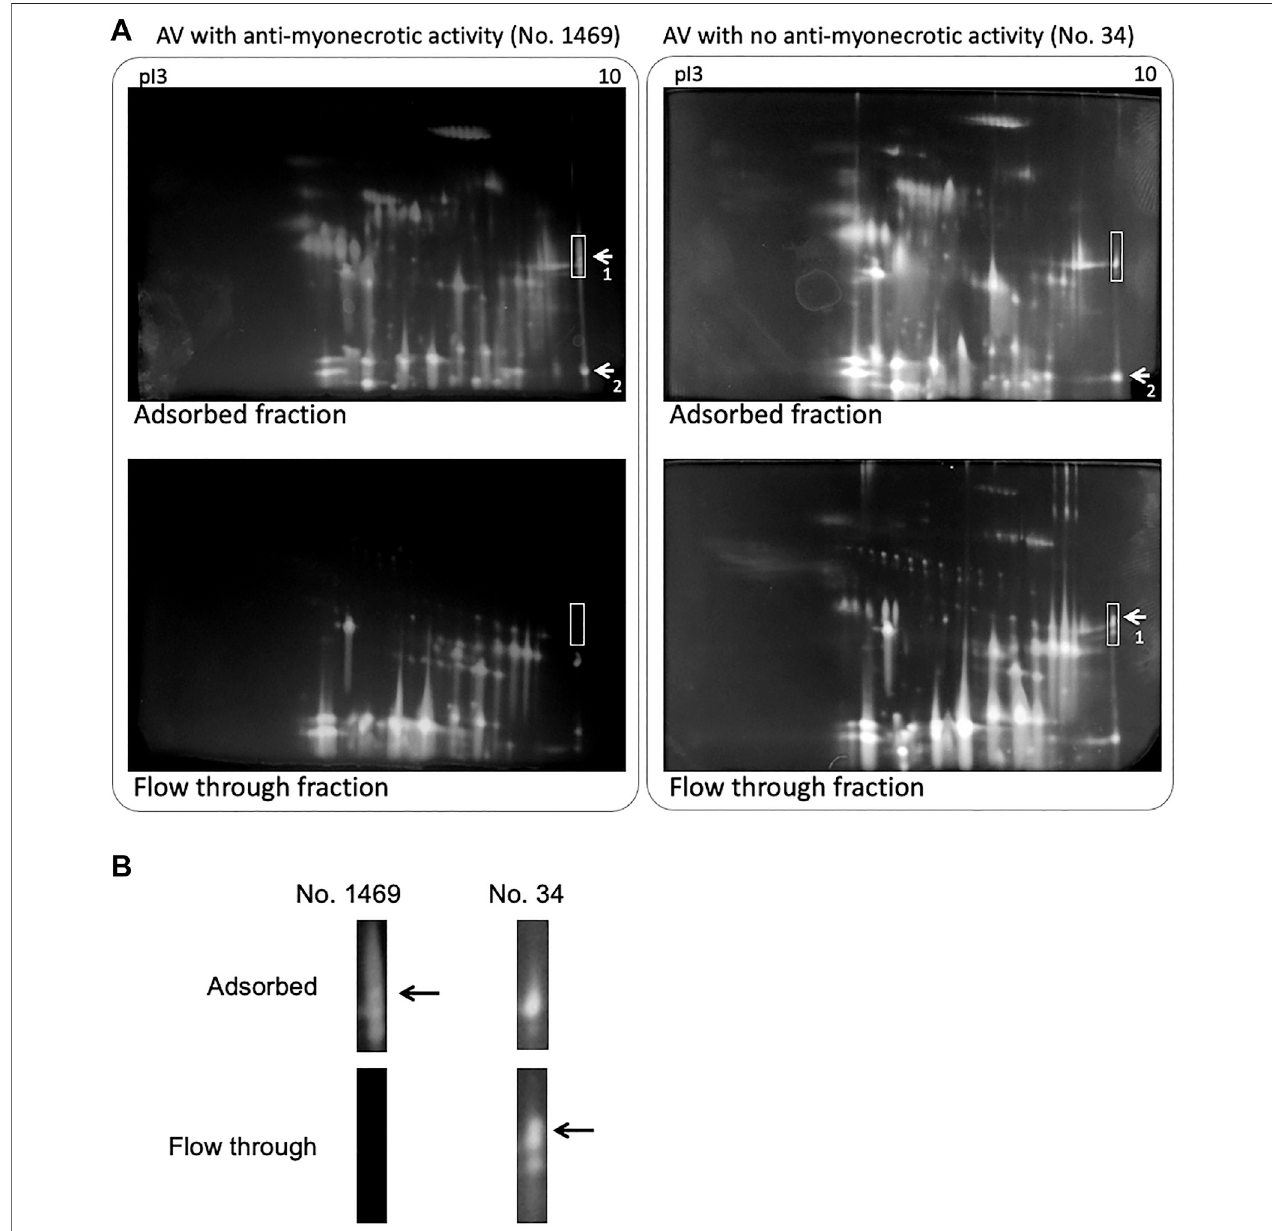
FIGURE2| 2DPAGEofhabucrudevenomseparatedbyantivenom(AV)-conjugatedaf fi nitychromatography. (A) 2DPAGEpro fi lesofadsorbed (upper) and fl ow throughfractions (down) onantivenom-conjugatedcolumnusinglotno.1469 (left) andlotno.34 (right) antivenoms,respectively.SampleswereloadedontheAuto2D BM-100 device using pI 3 – 10 and 12.5% gels. The protein spots were stained using the Silver Stain MS Kit. The labeled spots 1 and 2 indicated TLf2 and BPII proteins, respectively. Basic pI regions boxed with white lines were enlarged (B) . Arrows indicated TLf2 spot.